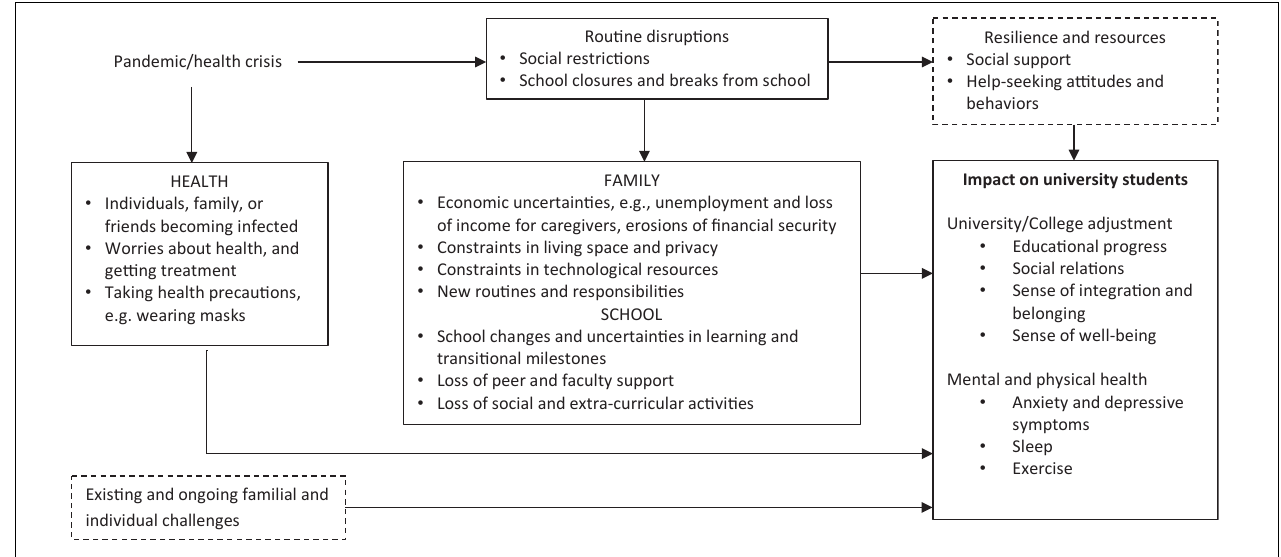
FIGURE 1 | Direct and indirect effects of COVID-19 on university students. Factors enclosed in dotted boxes were not investigated in this study.